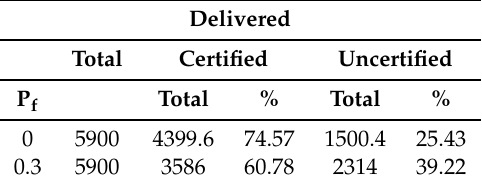
Table 4. Certification statistics for delivered notifications in the simulation of the collaborative architecture. Delivered